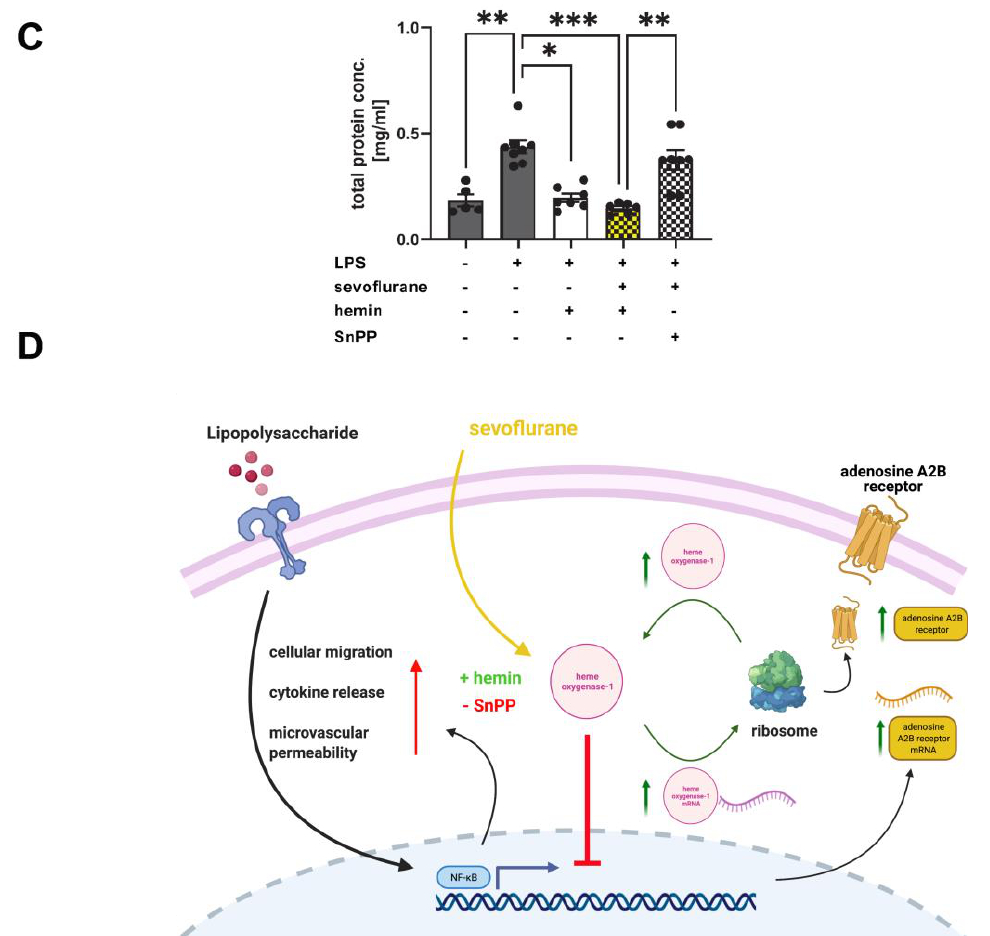
Figure 9. The additive effects of sevoflurane and heme oxygenase-1 (HO-1) activator on the release of inflammatory cytokines and microvascular permeability during acute lung injury. ( A ) The gene expression of tumor necrosis factor (TNF) α , interleukin (IL) 6, CXCL1, and CXCL2/3 in the lung tissue under the influence of HO-1 modulation during acute LPS-induced pulmonary inflammation was determined by real-time-polymerase chain reaction (RT-PCR) ( n = 6–12). ( B ) The TNF α , IL6, CXCL1, and CXCL2/3 release in the alveolar space was assessed after LPS exposure at indicated conditions by using enzyme-linked immunosorbent assay (ELISA) ( n = 6–8). ( C ) Additive effects of hemin activation on sevoflurane treatment during microvascular permeability were investigated. Evans blue extravasation in the pulmonary tissue were evaluated six hours after LPS stimulation at indicated conditions ( n = 6–8). ( D ) Schematic overview of sevoflurane effects on heme oxygenase-1 and adenosine A2B receptor expression during acute pulmonary inflammation. Images were created with BioRender. Statistical analyses were performed by one-way ANOVA + Bonferroni correction or Kruskal-Wallis test. Data are presented as mean ± SEM; * p < 0.05; ** p < 0.01; *** p < 0.001; **** p <